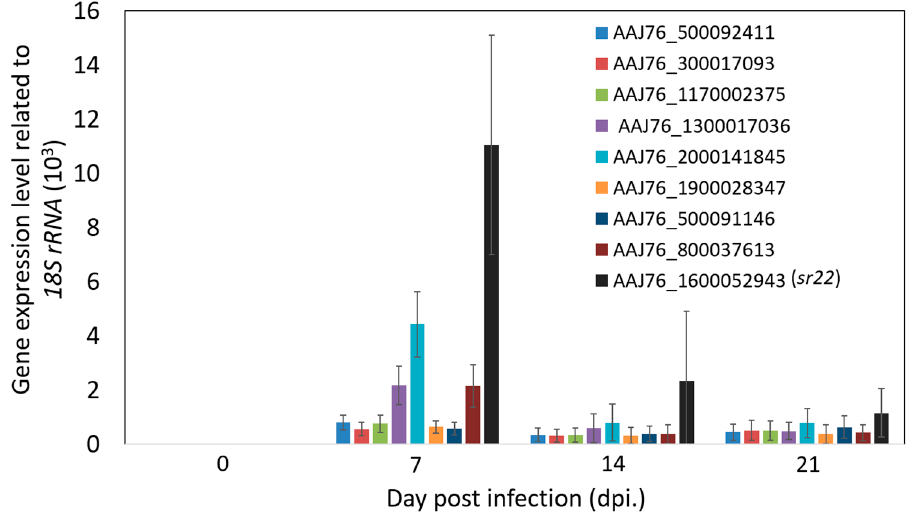
Figure 5. Validation of nine microsporidia specific gene expressions by RT-qPCR at 7, 14, and 21 dpi